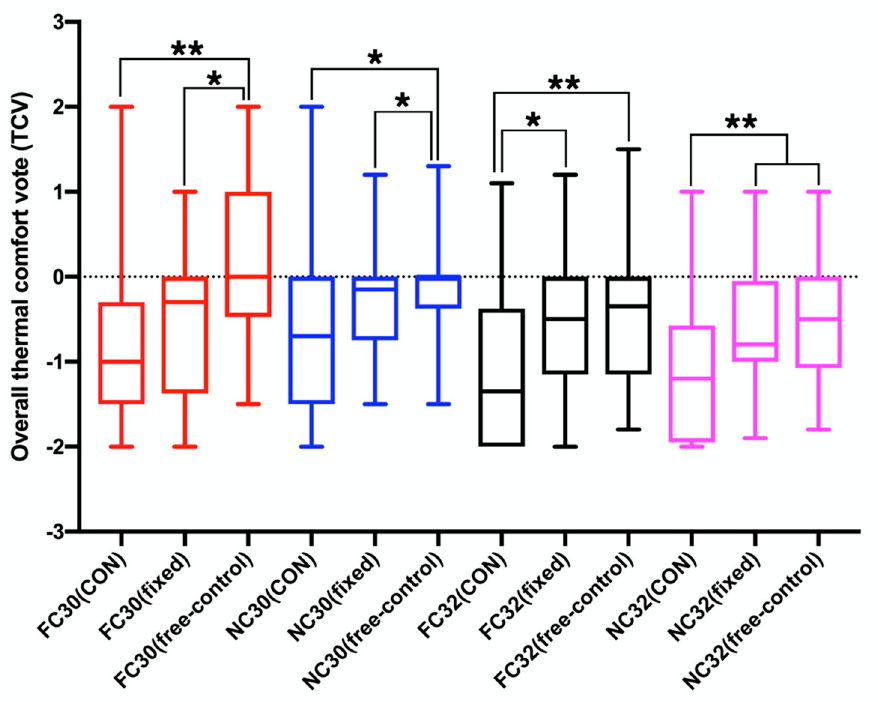
Figure 4. Overall thermal comfort votes (TCVs). *, p < 0.05; **, p < 0.001.